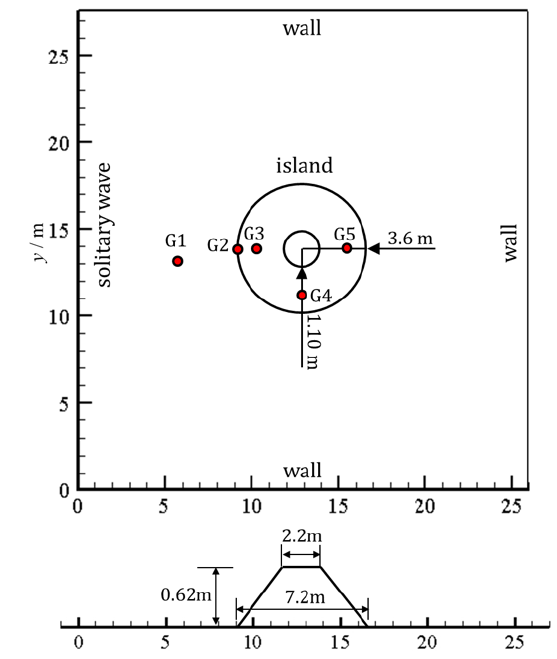
Figure 10. The experimental setup and bottom geometry for runup of a solitary wave on a circular island (Note: Red dots denote wave